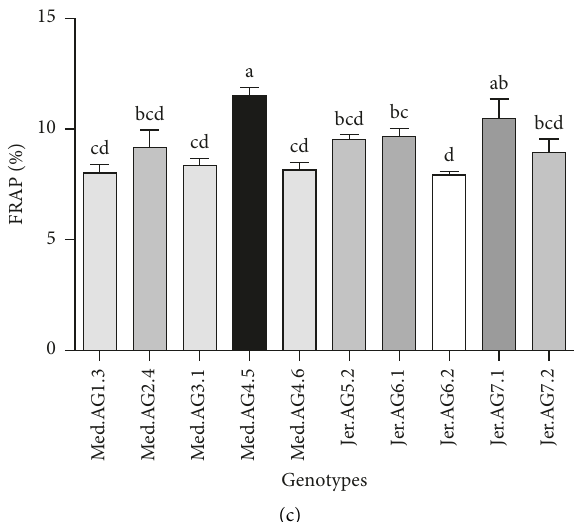
Figure 1: Antioxidant activities of grain extracts from the assessed millet genotypes; (a) ABTS, (b) DPPH, and (c) FRAP. Values are averages ± SD ( n � 3). Letters a–e denote statistical differences between assessed genotypes using Duncan’s multirange mean comparison test ( α �